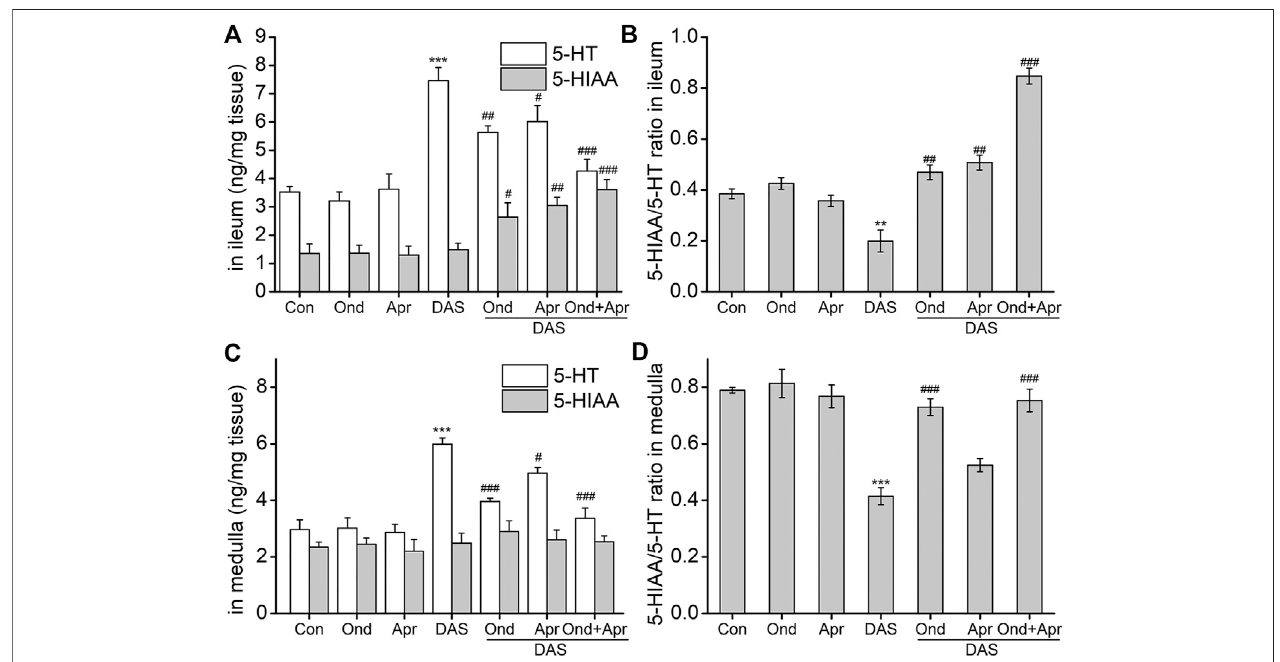
FIGURE 7 | The effect of Ond and Apr on the DAS-induced 5-HT, and 5-HIAA secretion, and the respective ratio (5-HT/5-HIAA) in the ileum and medulla of rats. Control: saline, p. o.; Ond: 1.66 mg/kg, p. o.; Apr: 26.2 mg/kg p. o.; DAS: 2 mg/kg, p. o. Ond and Apr were administered 30 min before DAS. The ileum and medulla werecollected4 haftertreatment(AandB-ileum;DandE-medulla).Theconcentrationsof5-HTand5-HIAAwereassessedusingHPLC-ECD.Thedataareexpressed as mean ± SEM. Statistical signi fi cance was assessed using the one-way ANOVA. * p < 0.05, ** p < 0.01, *** p < 0.001 vs. the control group, and # p < 0.05, # # p < 0.01, # # # p < 0.001 vs. the DAS group.